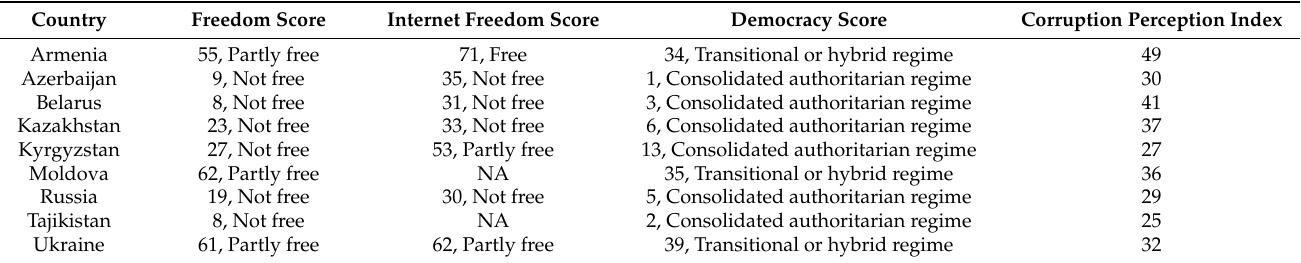
Table 4. Freedom Status and Corruption Perception